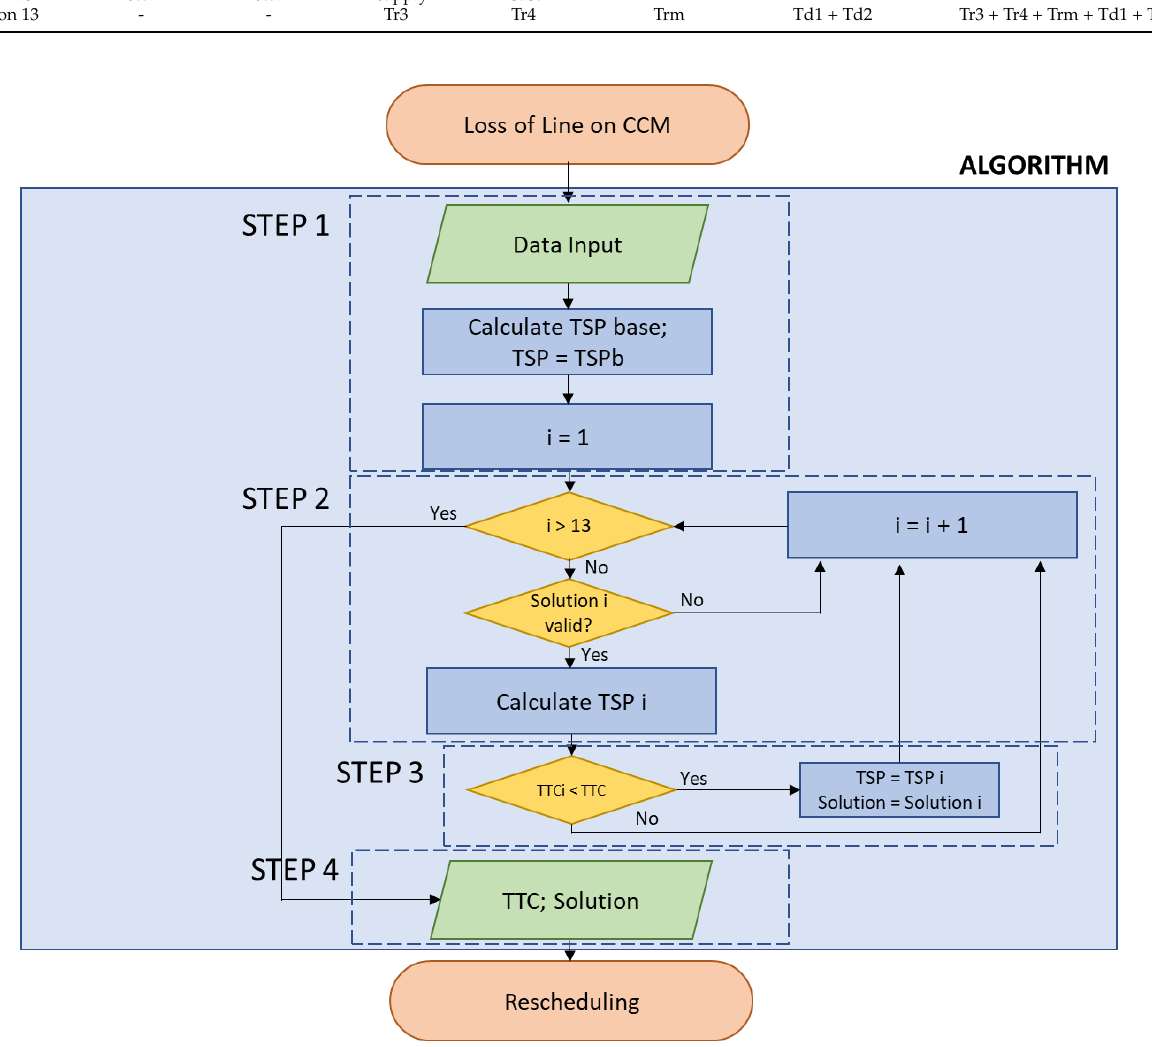
Figure 3. Algorithm flow chart.